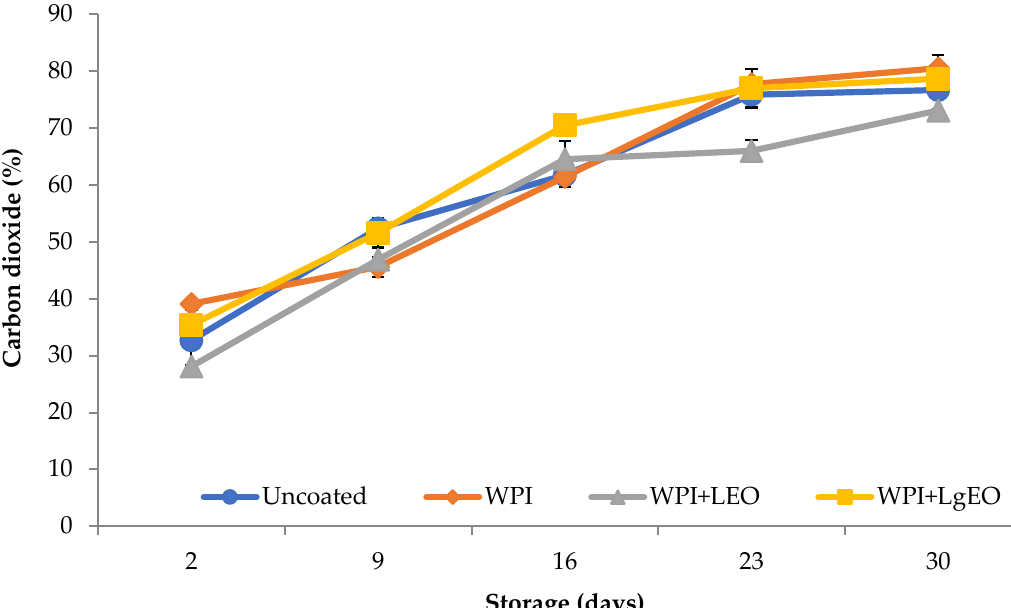
Figure 6. Carbon dioxide content in packaging of fresh-cut pears coated with whey protein isolate coatings (WPI) incorporated with lemon (WPI + LEO) and lemongrass (WPI + LgEO) essential oils or uncoated samples during 28 days of storage at 4 °C.